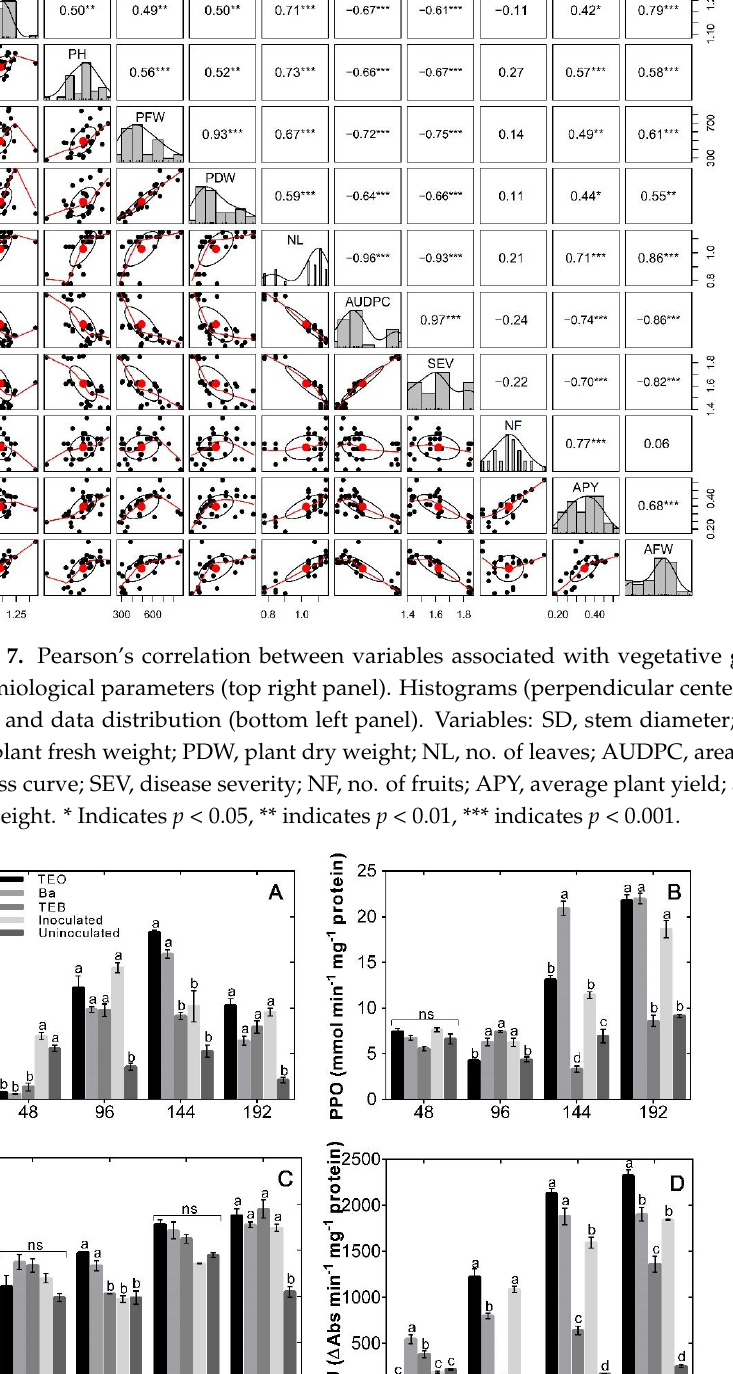
Figure 8. Defense-related enzyme activity in tomato plants var. Santa Clara infected by Alternaria linariae . ( A ) Peroxidase (POX), ( B ) polyphenol oxidase (PPO), ( C ) phenylalanine ammonia-lyase (PAL) and ( D ) β -1,3-glucanase (GLU). Treatments: thyme essential oil (TEO), Bacillus amyloliquefaciens MBI600 (Ba), tebuconazole (TEB); treatments were performed on inoculated and uninoculated plants. Bars with the same letters are not significantly different from each other by the Scott ‒ Knott test (p ≤ 0.05). Data represent th e average absorbance at different collection times, and deviation bars indicate the standard error of the mean.